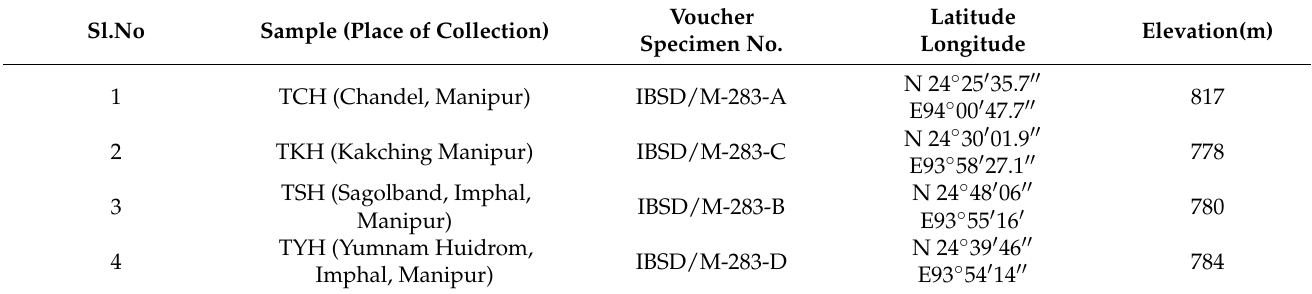
Table 5. Details of sample collection